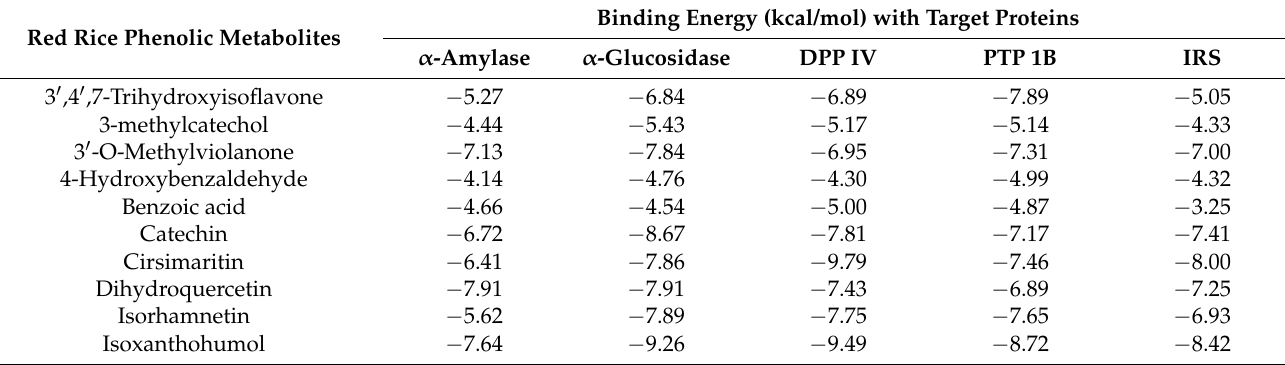
Table 4. The binding energy of red rice phenolic metabolites with target proteins involved in glucose metabolism. Red Rice Phenolic Metabolites